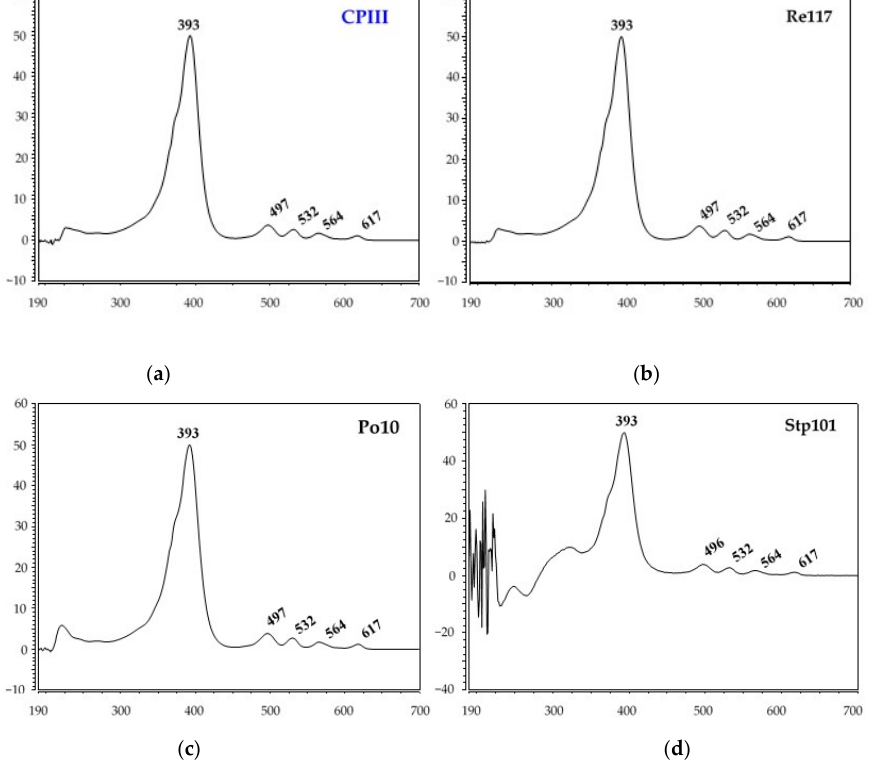
Figure 5. Comparison of absorption spectra of porphyrin standard, CPIII, and chromatographic peaks of the extracts exhibited at R t about 32 min: ( a ) CPIII standard; ( b ) G. arilaitensis Re117 at R t 32.75 min; ( c ) G. arilaitensis Po102 at R t 32.75 min; ( d ) G. arilaitensis Stp101 at R t 32.79 min.